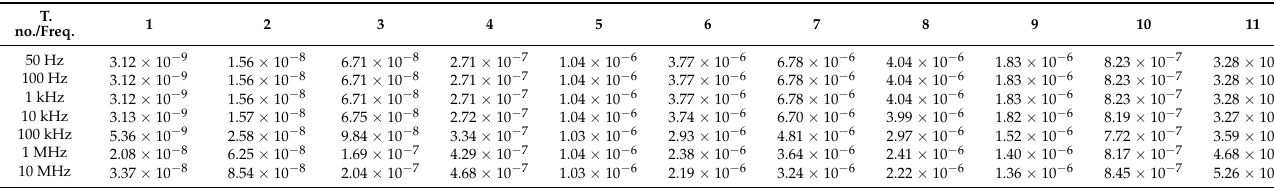
Table A6. Self and mutual inductances of turn 11 (in H) resulting from FEM